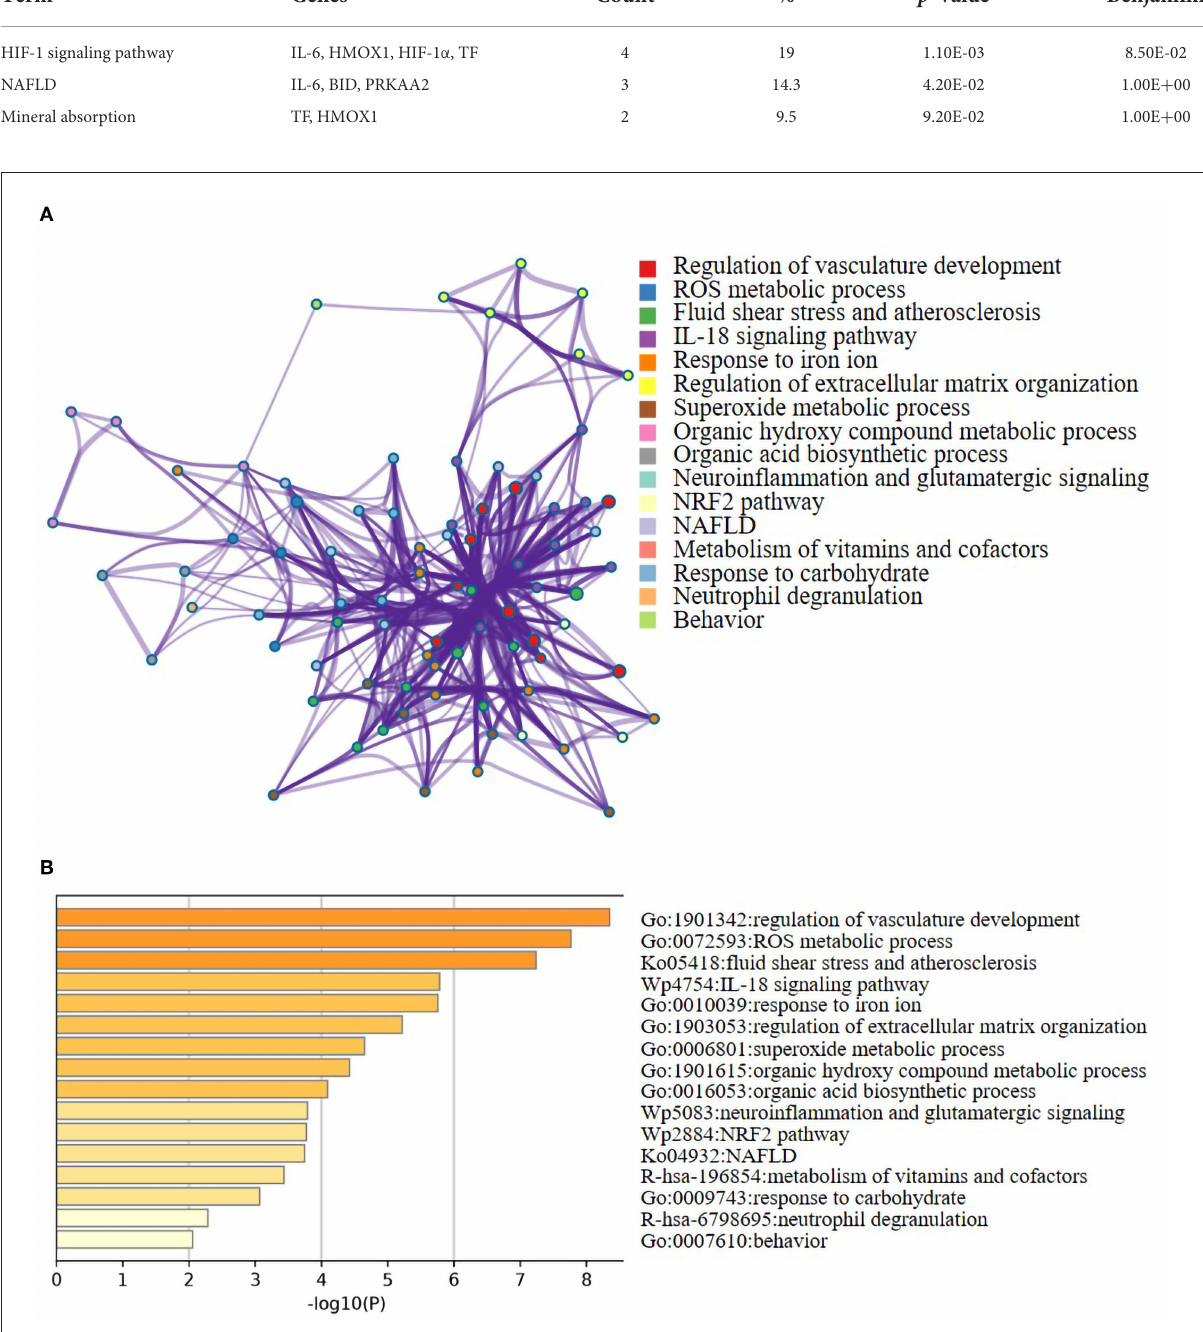
FIGURE3 Networks and the bar chart of enriched terms. (A) Networks of enriched terms of the 21 ferroptosis DEGs analyzed by Metascape. (B) The bar chart of 16 biological pathways based on the p -value ( < 0.01) and the percentage of the gene number.